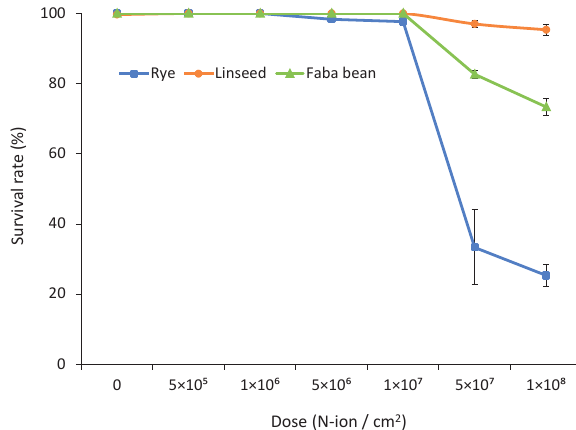
Fig. 1. Effect of ion beam irradiation on the survival rate of rye, linseed and faba bean. The error bars show ± 1 standard error of the mean.